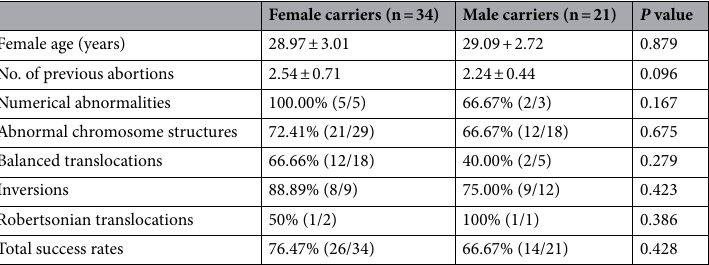
Table 3. Pregnancy outcomes of 34 RM couples with female carriers and 21 RM couples with male carriers.